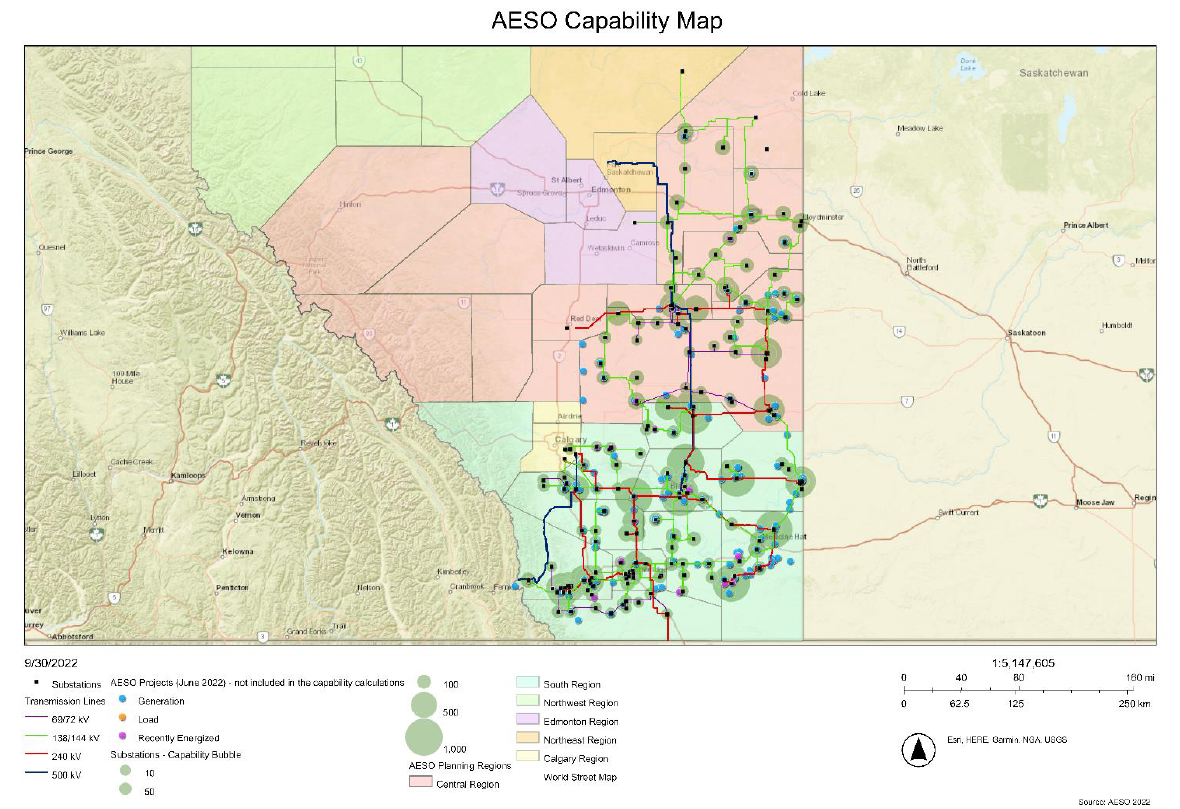
Figure 2. Alberta electricity Map.